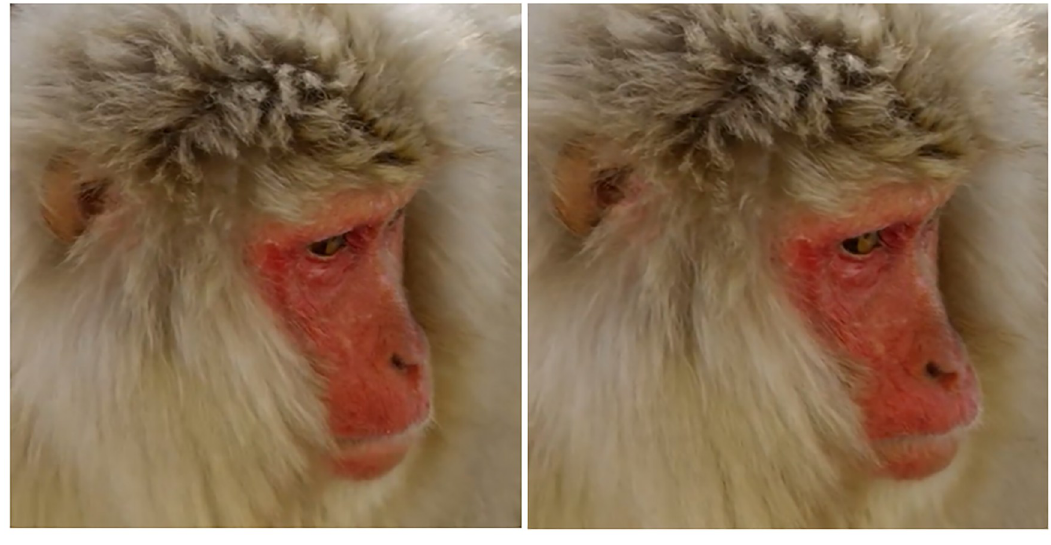
Fig 16. Left: Neutral; Right: